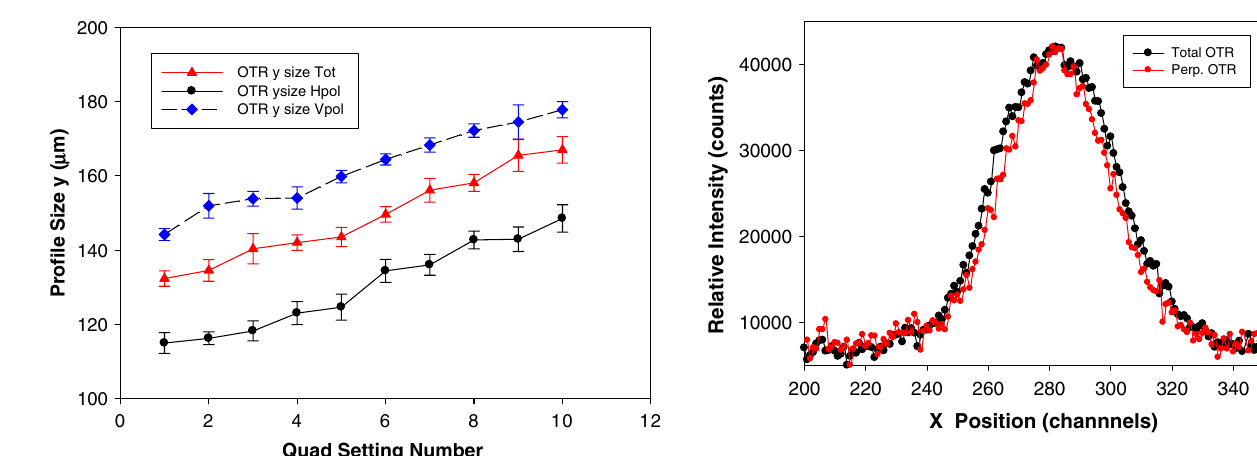
FIG. 11. Comparison of the total OTR projected profiles in y (red), horizontally polarized (Hpol) results (black), and verti- cally polarized (Vpol) OTR results (blue) as a function of upstream quadrupole (Quad) settings at 4.5 GeV.